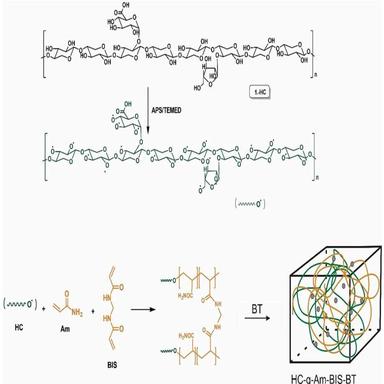
Proposed reaction mechanism for HC-g-Am-BIS-BT hydrogels.